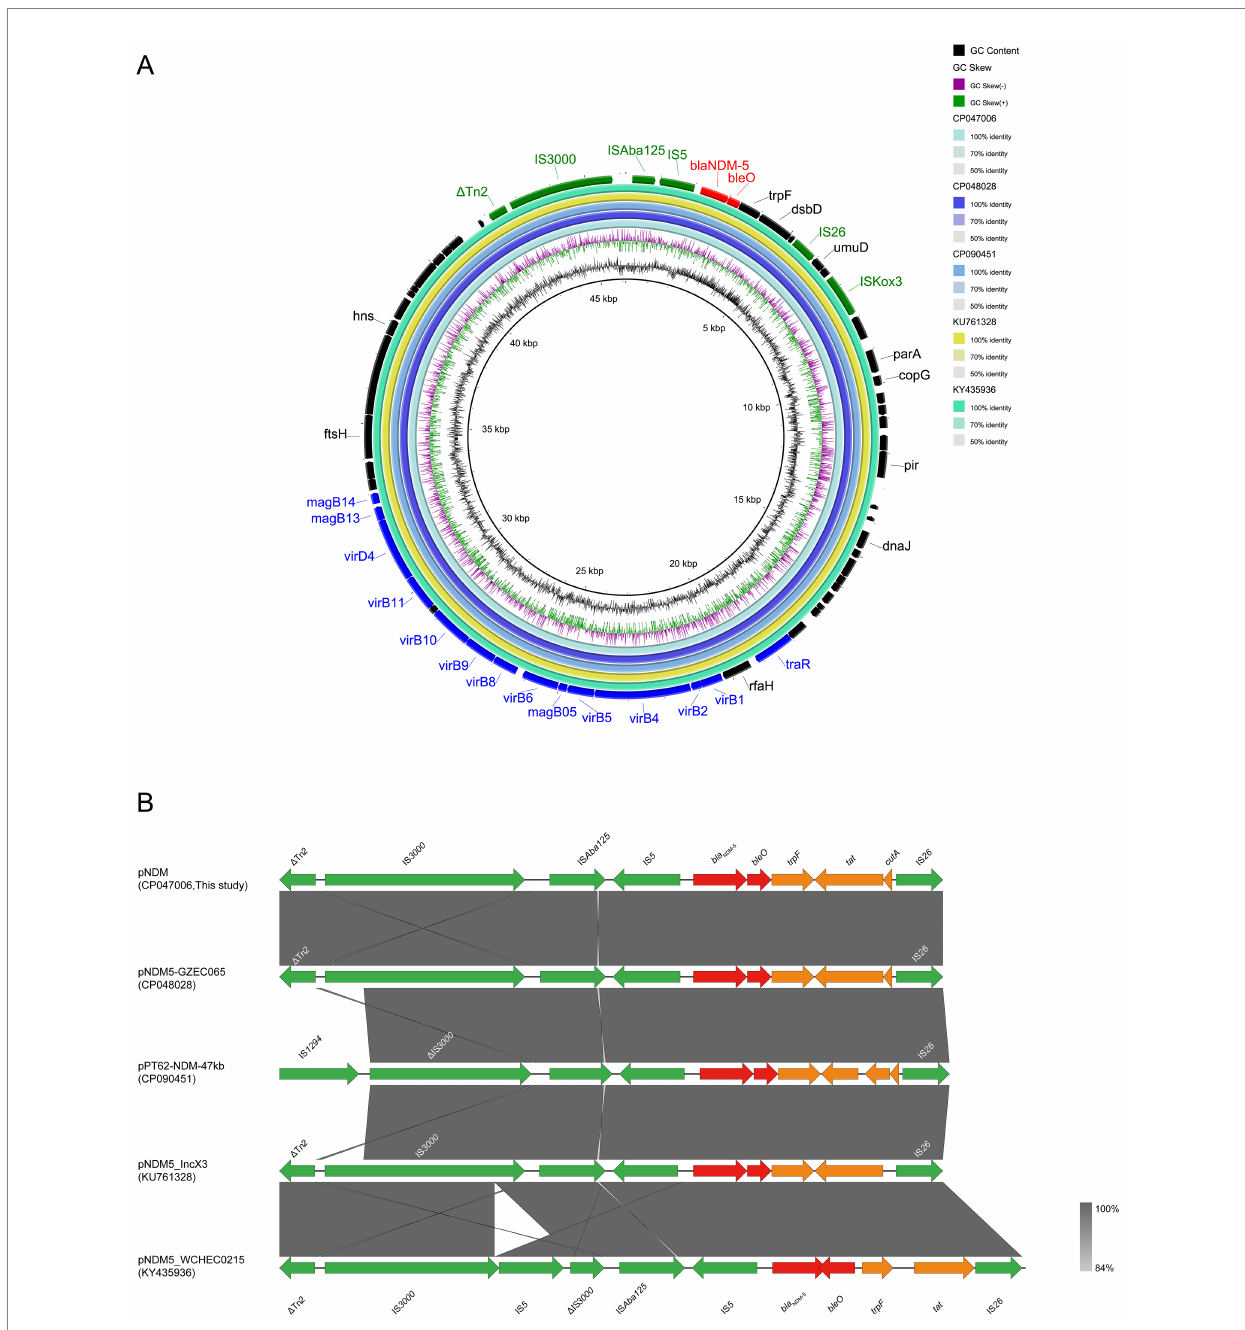
FIGURE 5 Comparative genomic analysis of bla NDM-5 -carrying IncX3-type plasmid pNDM (CP047006, this study) with pNDM5-GZEC065 (CP048028), pPT62- NDM-47 kb (CP090451), pNDM5_IncX3 (KU761328) and pNDM5_WCHEC0215 (KY435936) (A) . The plasmid pNDM was used as a reference sequence, and dark colors represent other genes; blue colors represent relaxase, type IV secretion system (T4SS) and type IV coupling protein (T4CP); green colors represent insertion sequences (IS); red colors represent antimicrobial resistance (AMR) genes. Genetic environment of bla NDM-5 located on plasmid pNDM compared with pNDM5-GZEC065, pPT62-NDM-47 kb, pNDM5_IncX3 and pNDM5_WCHEC0215 (B) . Dark grey shading denotes regions of homology (>99% identity nucleotide identity). Orange colors represent other genes; green colors represent insertion sequence (IS) and transposon (Tn); red colors represent antimicrobial resistance (AMR)